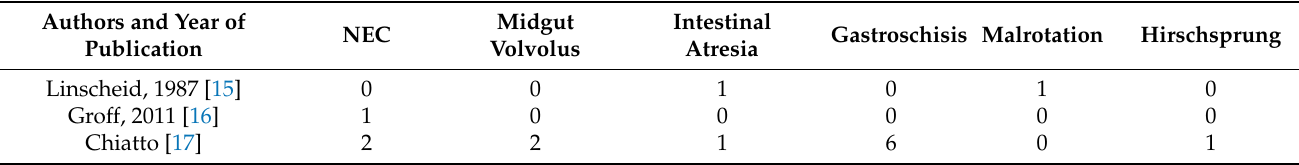
Table 3. Causes of intestinal resection.